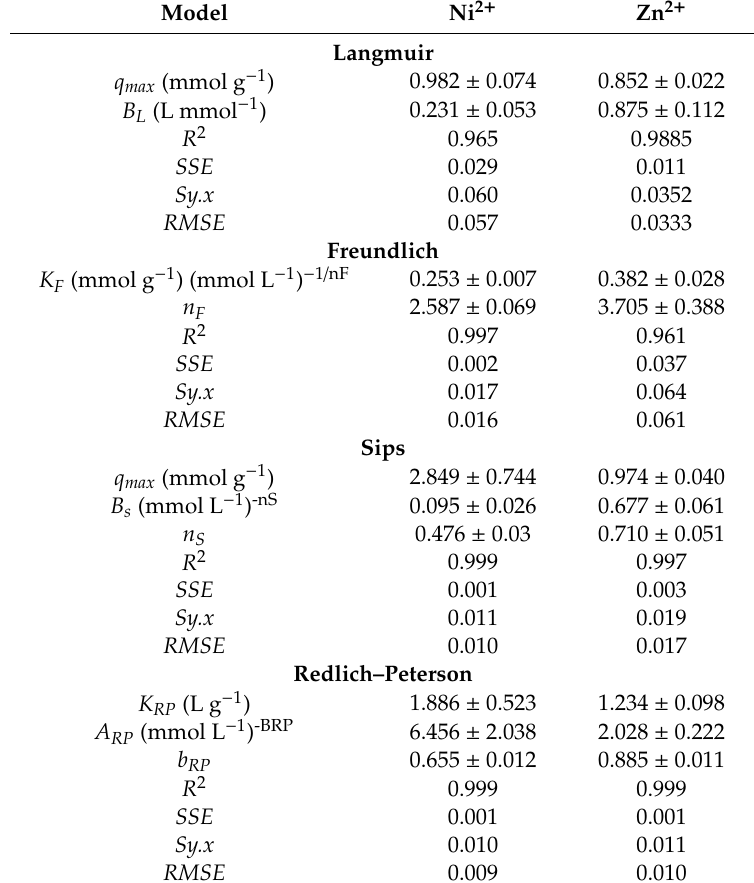
Table 5. Isotherm model parameters for Ni 2 + and Zn 2 + biosorption in single metal